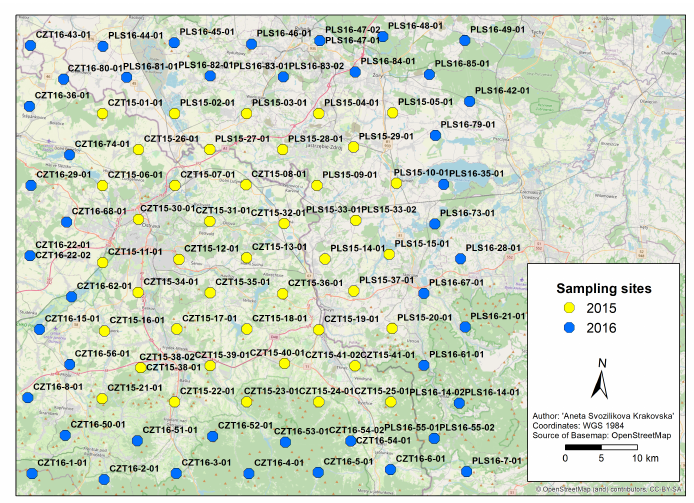
Figure 4. Map of sampling